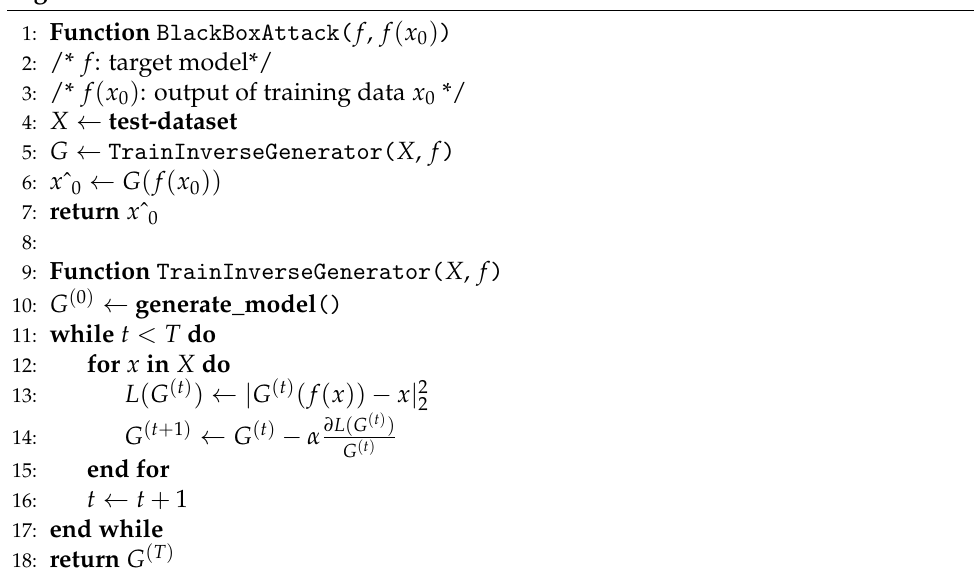
Algorithm 1 Reconstruction Attack